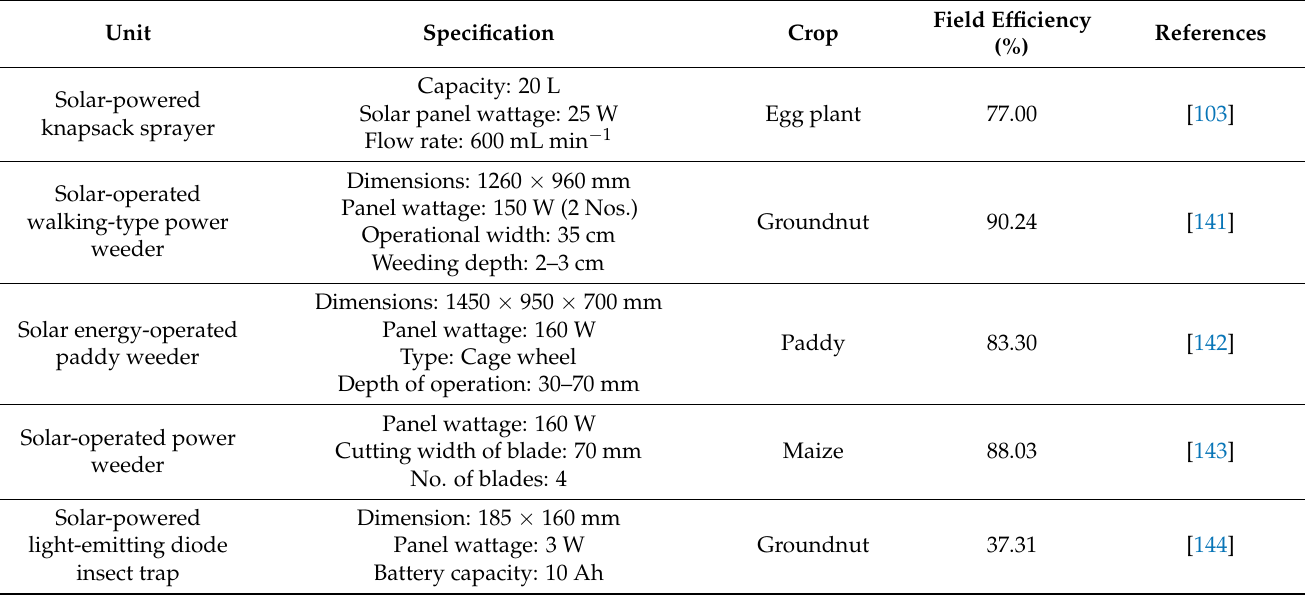
Table 6. Efficiency of different solar-powered plant protection devices used in agriculture.